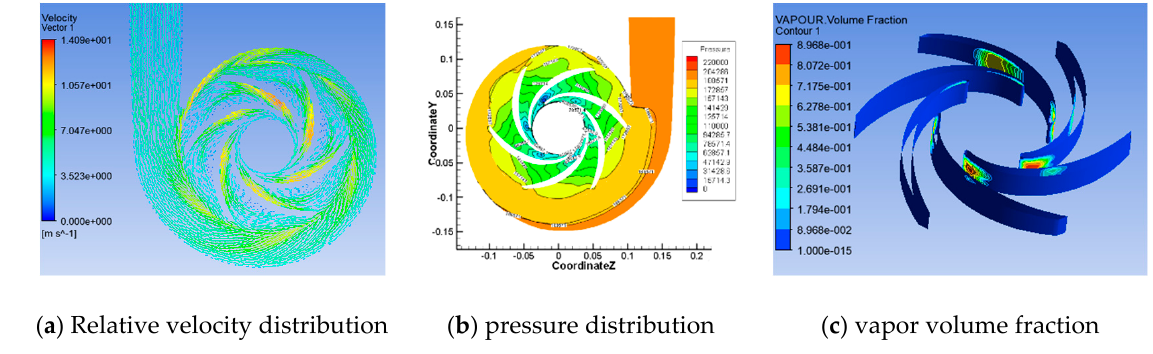
Figure 14. Flow field information of VTB 4-8-4.